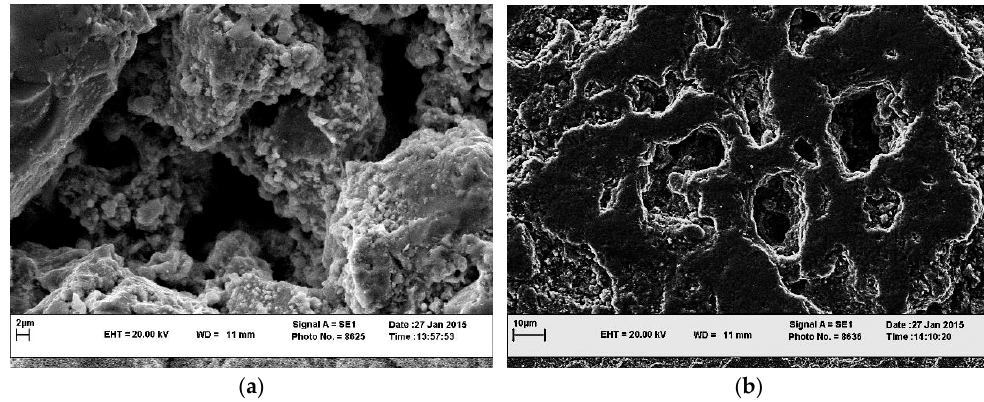
Figure 4. SEM images of Ti matrix foams sintered at 1050 °C: ( a ) with 1.5 wt % SiC; and ( b ) with 0.5 wt % SiC.